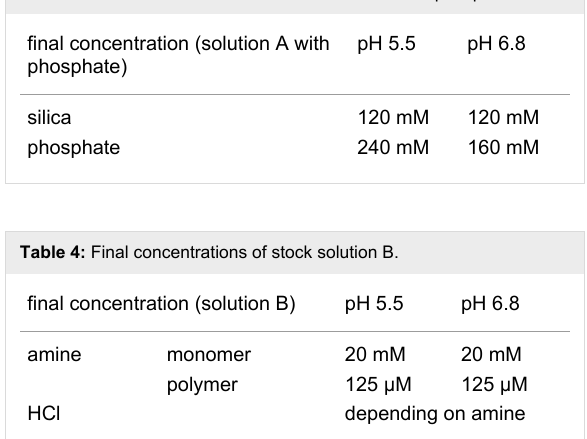
Table 3: Final concentrations of stock solution A with phosphate.